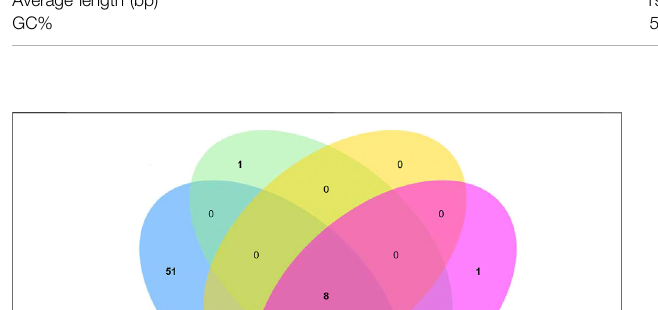
TABLE 3 | The number of contigs of four DNA barcodes in the Qingguo Wan samples. Parameter Number of unique contig